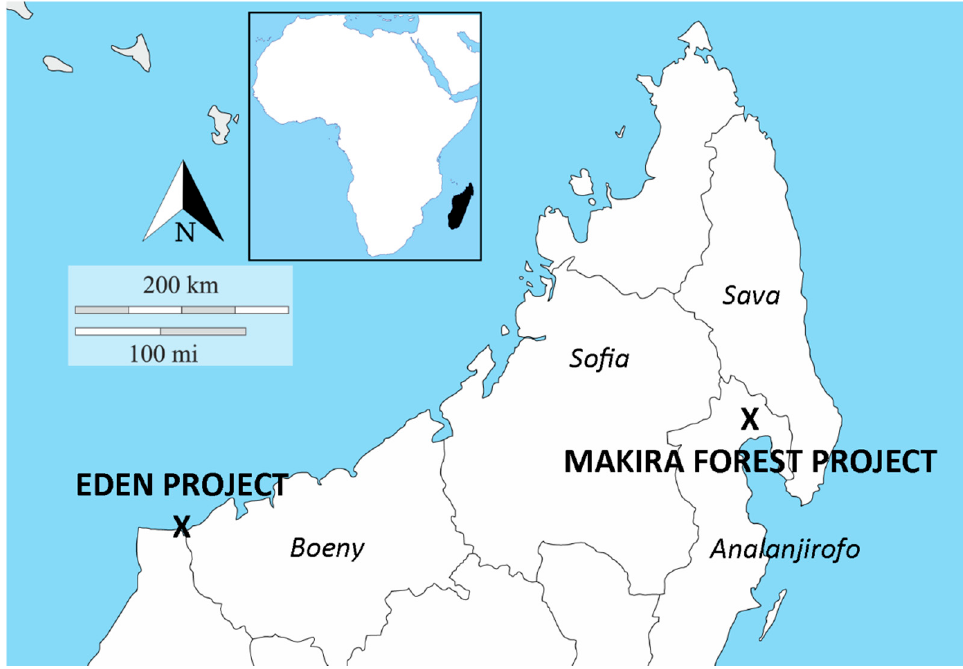
Figure 1. Forest restoration and rehabilitation case study projects, Madagascar. Source: Adapted from D-Maps, 2018 [32].